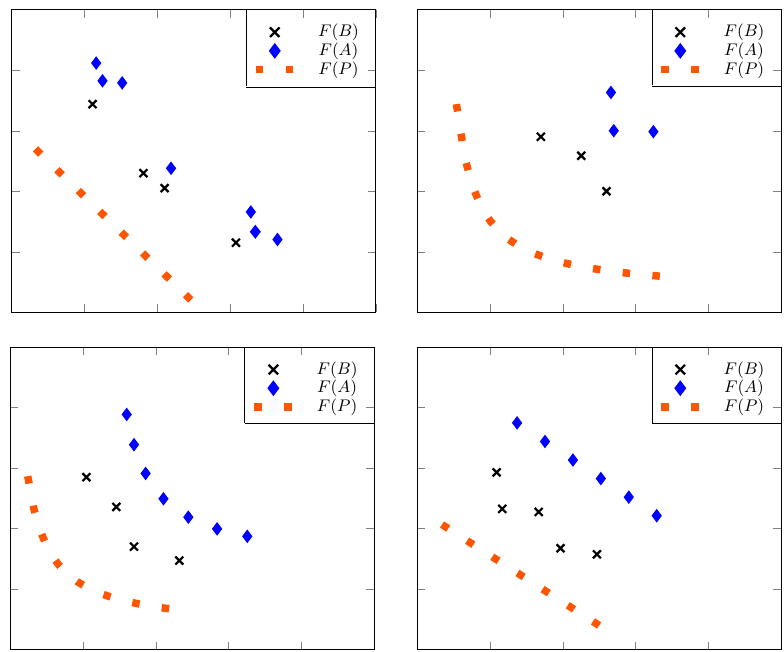
Figure 5. Four examples where IGD p ( B ) is smaller (better) than IGD p , q ( A ) for sufficiently negative q : In each case, at least one of the requirements of Theorem 6 is